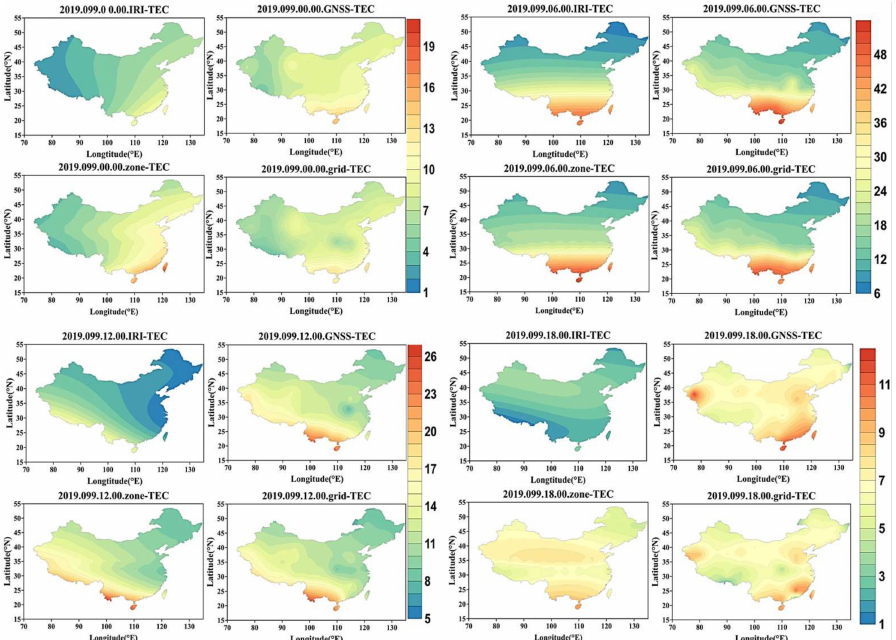
Figure 6. 2-D distributions of GNSS-TEC, the TEC estimates calculated using the original IRI-2016 model, and the TEC estimates obtained using schemes A and B in the parts of China region at the four time points of 0, 6, 12, and 18 UT on April 9 (DOY099) in